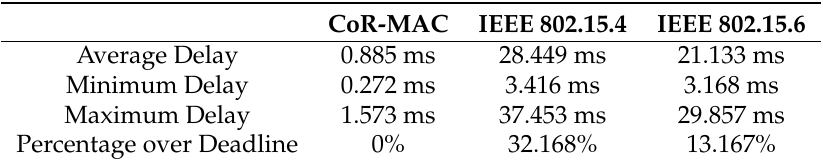
Table 3. Delay statistics of urgent data with 15 nodes.